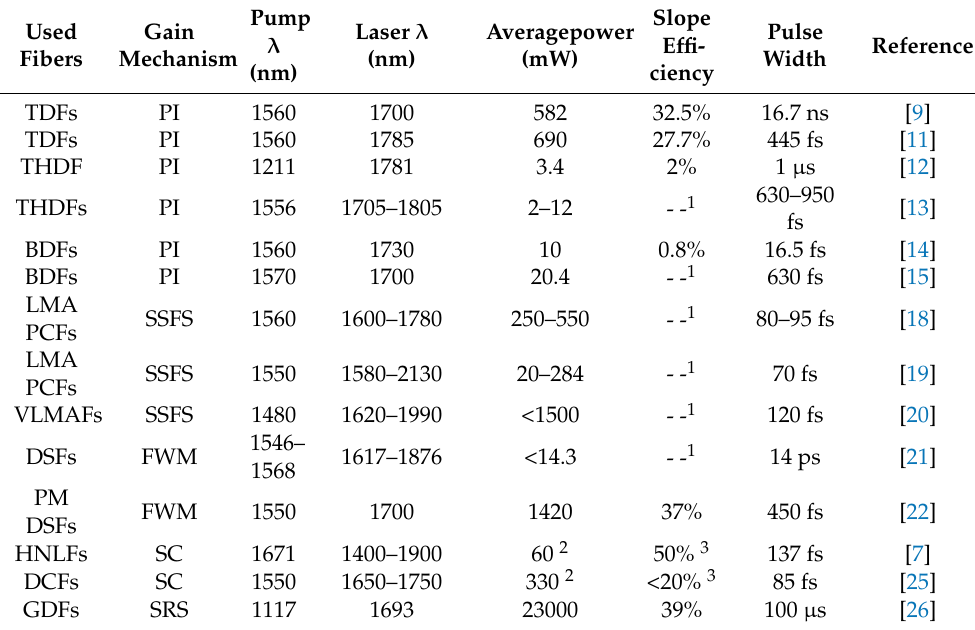
Table 1. Characteristics of 1.7 µ m pulsed fiber lasers based on solid-core